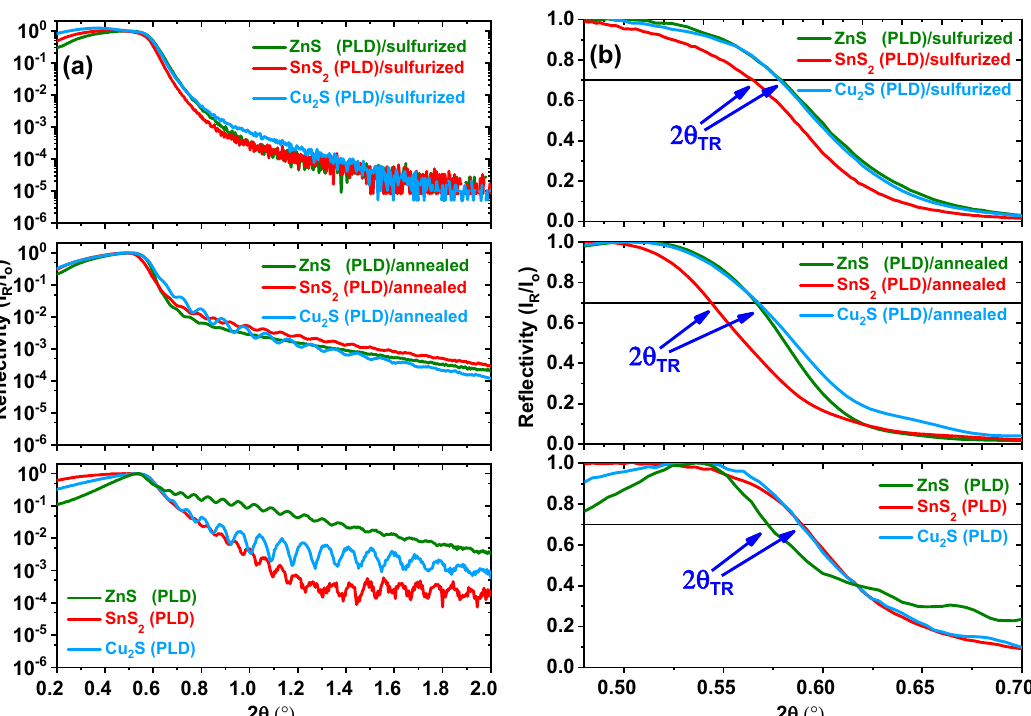
Figure 1. ( a ) XRR diagrams for co-deposited CZTS thin films in the as-deposited state, after annealing at 500 ◦ C and after sulfurization at 500 ◦ C. ( b ) Positions of the total reflection edge (2 θ TR ), defined as the angle for which the reflectivity decreases by 30% of the maximum. Table 1. Position of the total reflection edge (2 θ TR ) and the average thickness (h m ) (as well as their relative variation) of the as-deposited, annealed, and sulfurized CZTS thin films.